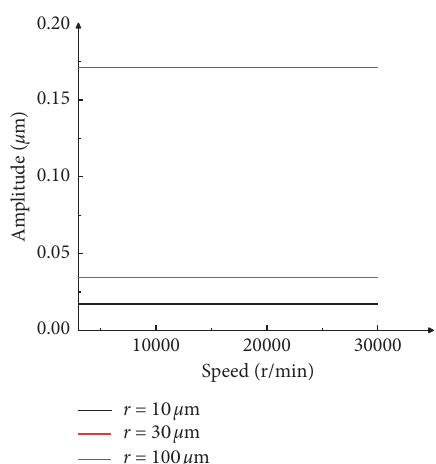
Figure 14: Effect of different static eccentricity on vibration with the increase of rotating speed.